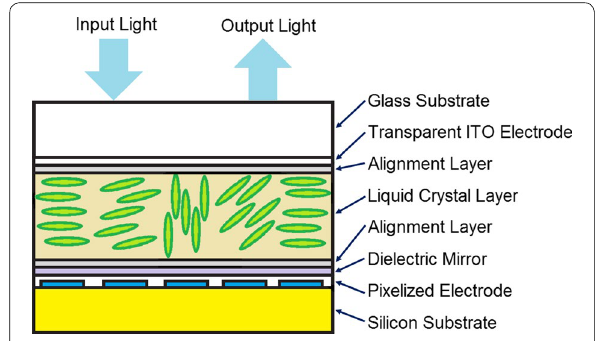
Fig. 4 Configuration of the LCOS-SLM device, consisting of trans- parent top glass substrate with transparent indium tin oxide (ITO) electrode, alignment layers, liquid crystal material, reflective mirror, pixelized electrode structure and silicon substrate (Adapted from Matsumoto et al.